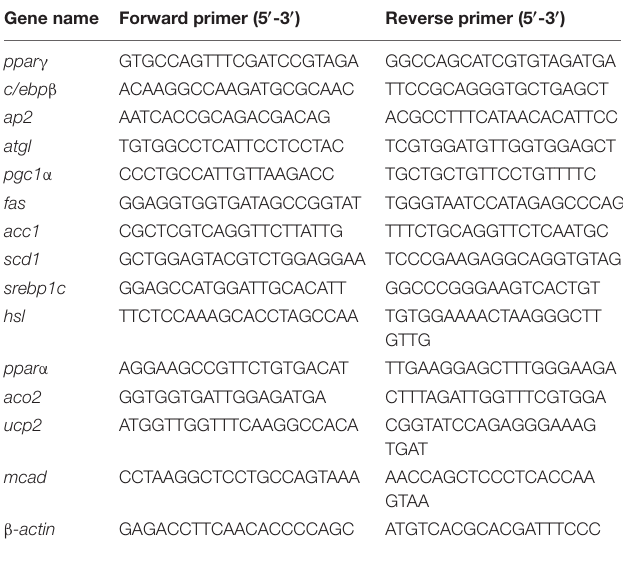
TABLE 1 | qRT-PCR primers used in this